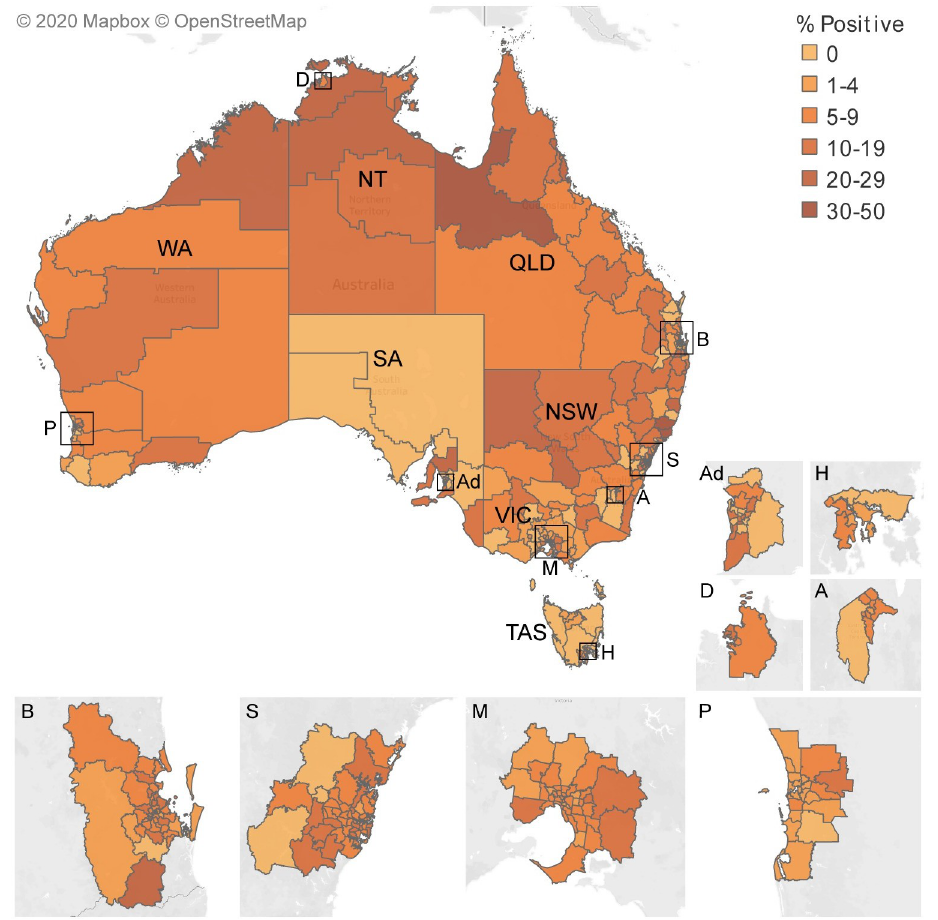
Fig 3. Strongyloides serology: map 1 showing percent positive of those tested, 2012–2016, (excluding data from the laboratory that provided positive data only 2 ) for each ABS statistical area level 3 (region) in each state and Greater Capital City. 1 This map was created using our data, Tableau software, an ABS shapefile and a Mapbox base map. 2 Most of SA shows 0% positive because there was no negative data from the laboratory in SA. The % positive for the two southernmost SA3s in NT are likewise underestimated. A = ACT; Ad = Adelaide; B = Brisbane; D = Darwin; H = Hobart; M = Melbourne; P = Perth; S = Sydney; NSW = New South Wales; NT = Northern Territory; QLD = Queensland; SA = South Australia; TAS = Tasmania; VIC = Victoria; WA = Western Australia.